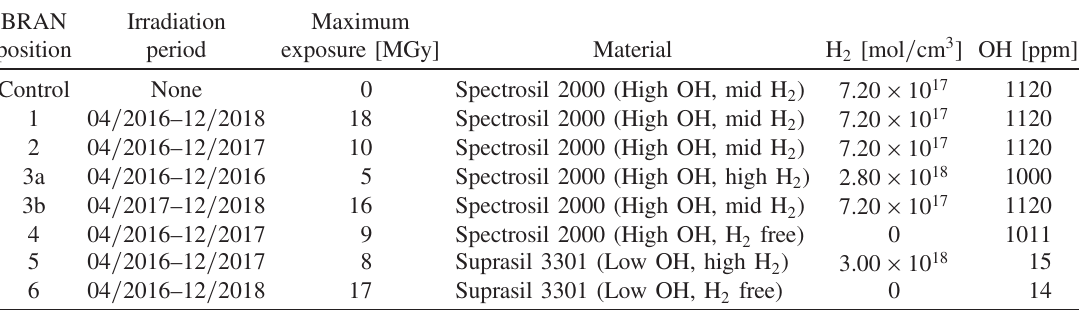
TABLE I. Fused silica rod specifications. The number ID assigned to each rod corresponds to a given position in the detector, as shown in Fig. 1. The rods were doped with different levels of hydroxyl (OH) and hydrogen (H 2 ) to carry out optical transmission studies [13]. Rods 3a and 3b occupied the same slot, but at different